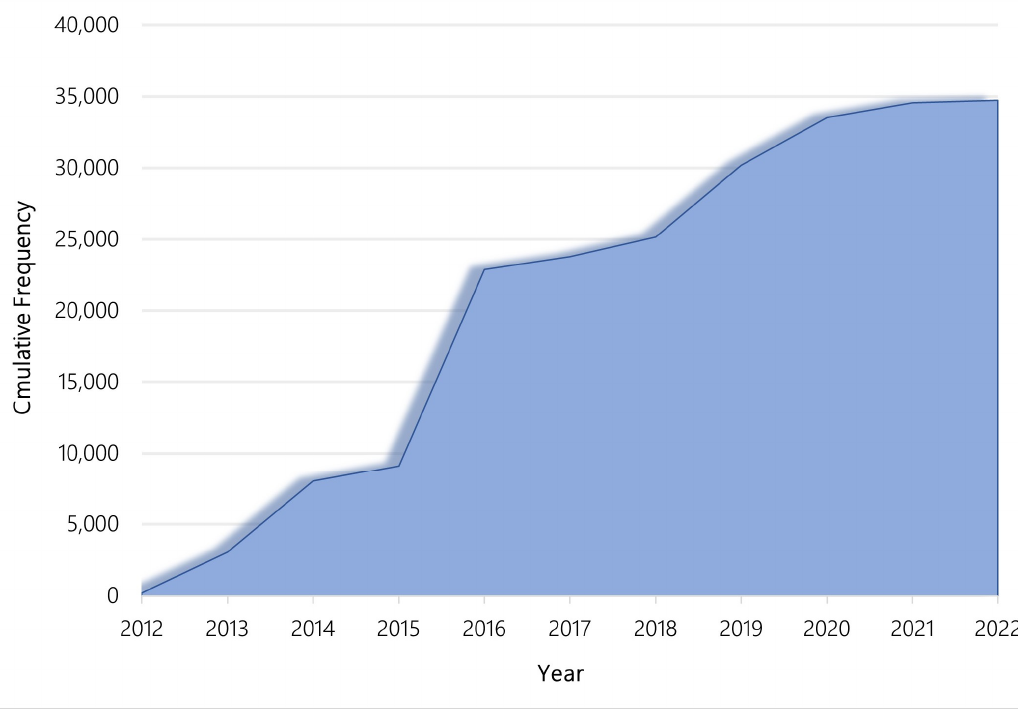
Figure 2. Cumulative frequency of current genetic tests per year,